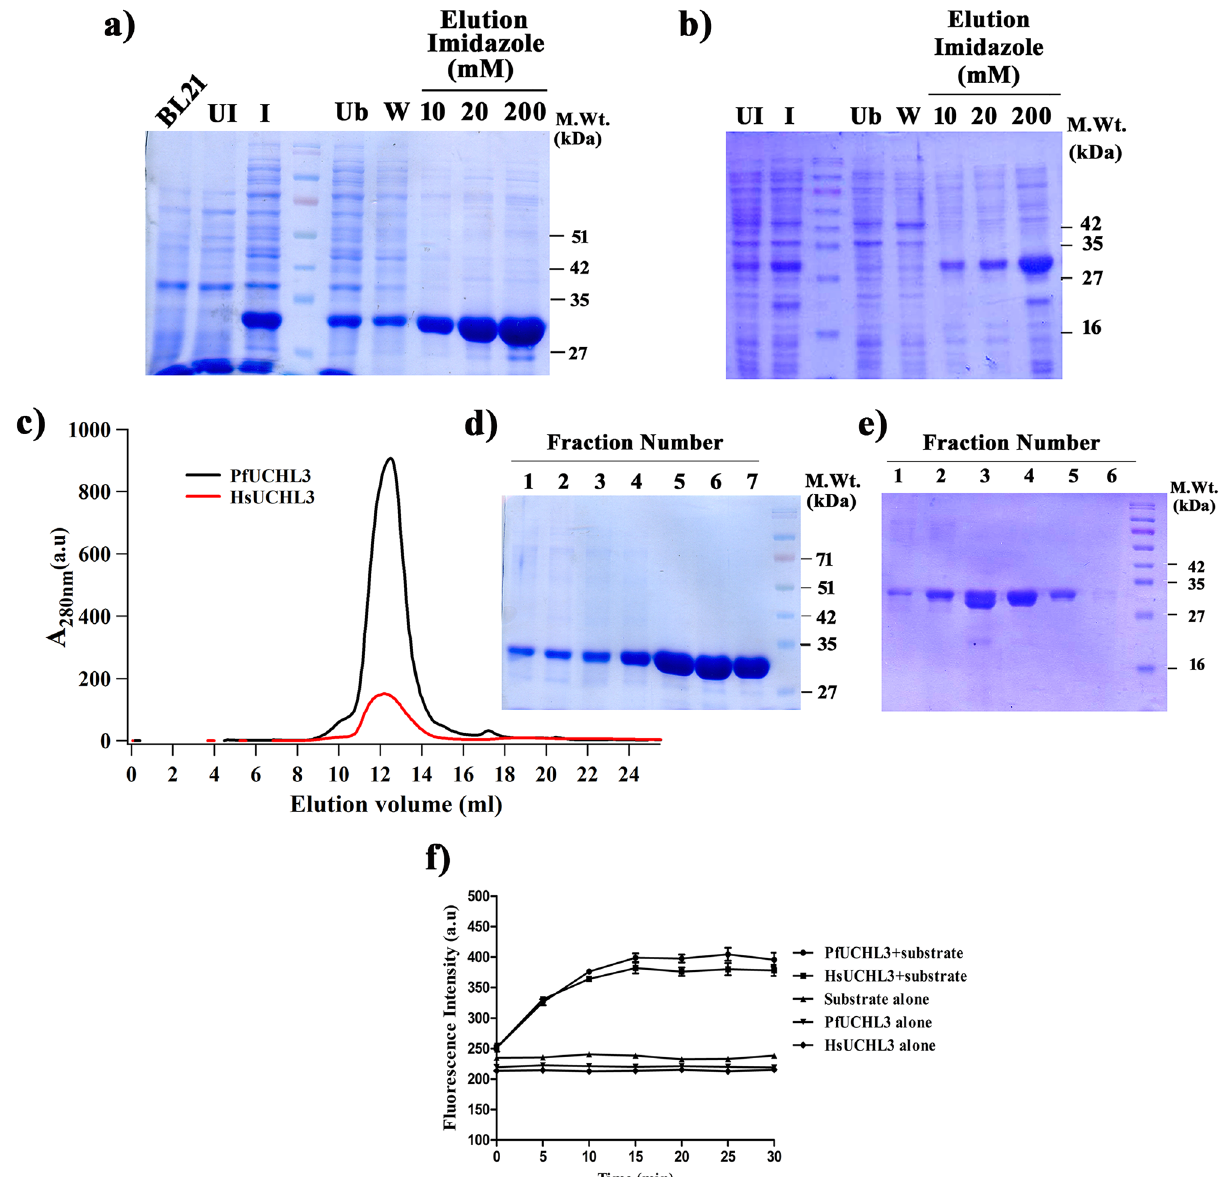
Figure 2. Expression, purification and deubiquitinating activity of PfUCHL3 and HsUCHL3: ( a ) PfUCHL3 and ( b ) HsUCHL3 were expressed in BL21 (λDE3) and purified using Ni-affinity chromatography, UI-uninduced, I-induced, Ub-unbound, W-wash. The proteins were further purified by gel filtration chromatography using AKTA prime. ( c ) The FPLC profile denotes a single peak for both the enzymes. Both ( d ) PfUCHL3 and ( e ) HsUCHL3 were purified to homogeneity as determined by SDS-PAGE analysis. ( f ) The catalytic activities of both the enzymes were assessed by measuring the change in fluorescence intensity, substrate and enzyme alone were taken as negative control. Uncropped images of commassie stained SDS gels are provided in Supplementary Fig.